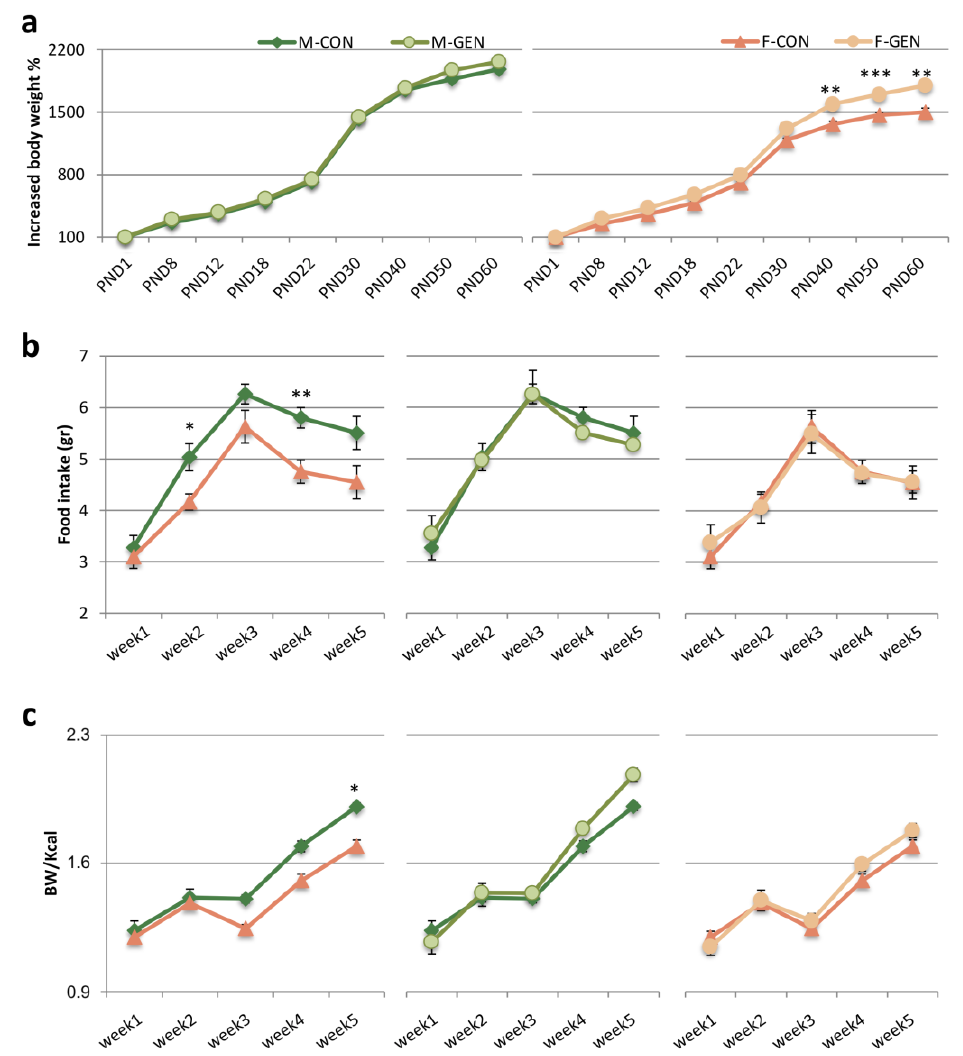
Figure 8. Metabolic parameters. ( a ) Lines representing the increase of body weight in percentage, with the weight at PND1 = 100 (mean ± SEM) during the development of male control (M-CON) vs. male-treated (M-GEN), on the left, and female control (F-CON) vs. female-treated (F-GEN), on the right. ( b ) Variations of the amount of food intake expressed in grams (mean ± SEM) during five weeks after weaning in both sexes (M-CON, M-GEN, F-CON, F-GEN). On the left a comparison among control males and females; the other two diagrams illustrate the comparison within each sex among control and genistein-treated mice. ( c ) Variations of the daily feed efficiency (body weight/kcal introduced; mean ± SEM) calculated during five weeks after weaning in both sexes (M-CON, M-GEN, F-CON, F-GEN). On the left a comparison among control males and females; the other two diagrams illustrate the comparison within each sex among control and genistein-treated mice. * p < 0.05; ** p ≤ 0.01; *** p ≤ 0.001; (Bonferroni test). Feed efficiency (body weight gain/Kcal) was analyzed using two-way ANOVA for repeated measures (independent variables: sex and treatment, repeated measure: feed efficiency) showing a global effect of sex (F = 6.722 and p = 0.0017), but no effect of treatment (F = 0.704 and p = 0.411). The multiple comparisons between groups displayed a sexual dimorphism in controls, with a significant increase in M-CON vs. F-CON in the last week of the experiment (from PND53 to PND60; Tukey test, p = 0.038). This difference was present also between M-GEN and F-GEN at week 3 ( p = 0.05) and week 4 ( p = 0.03; Figure 8c). GEN treatment did not alter feed efficiency either in males or females (Table S6).